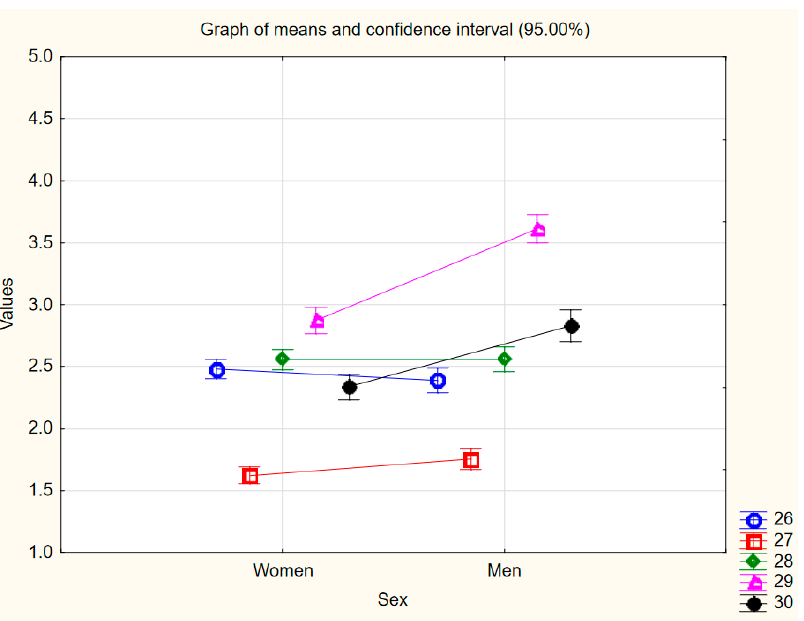
Figure 6. Categorized mean values of the semantic differential regarding the characteristics of nuclear power (own research). Theses numbers: 26—The use of water by nuclear power is (1—large; 5—small); 27—the disposal of radioactive waste is (1—difficult; 5—easy); 28—how does a nuclear power plant affect the labor market? (1—reduces the number of jobs; 5—increases the number of jobs); 29—the risk of nuclear power plant failure is (1—high; 5—low); 30—the risk of food contamination through nuclear power plant failures is (1—high; 5—low).